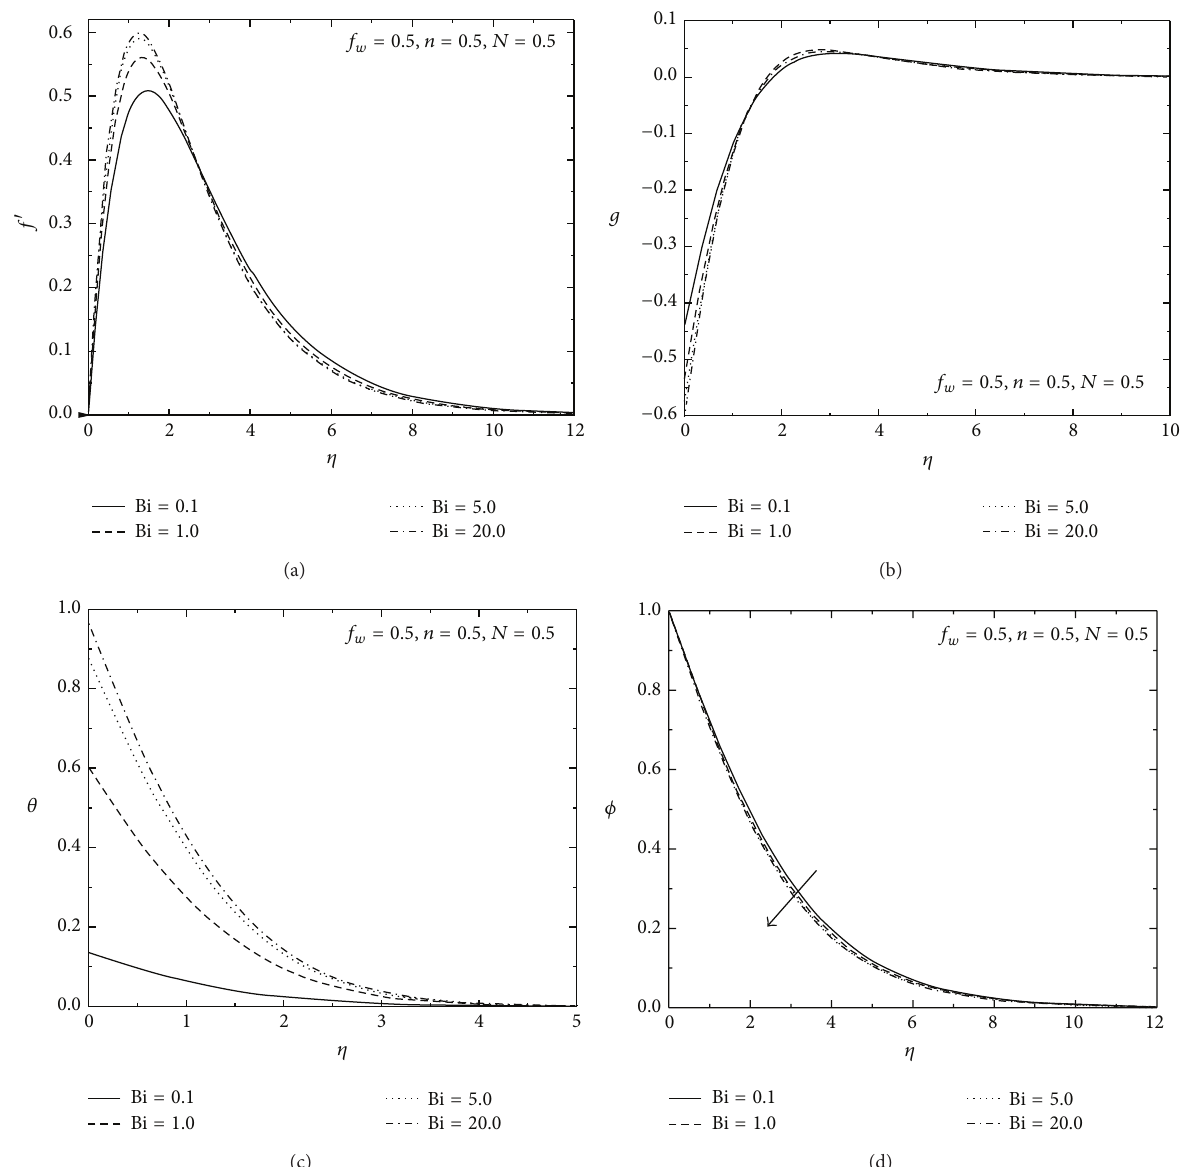
Figure 3: Effect of Bi on (a) velocity, (b) microrotation, (c) temperature, and (d) concentration profiles.